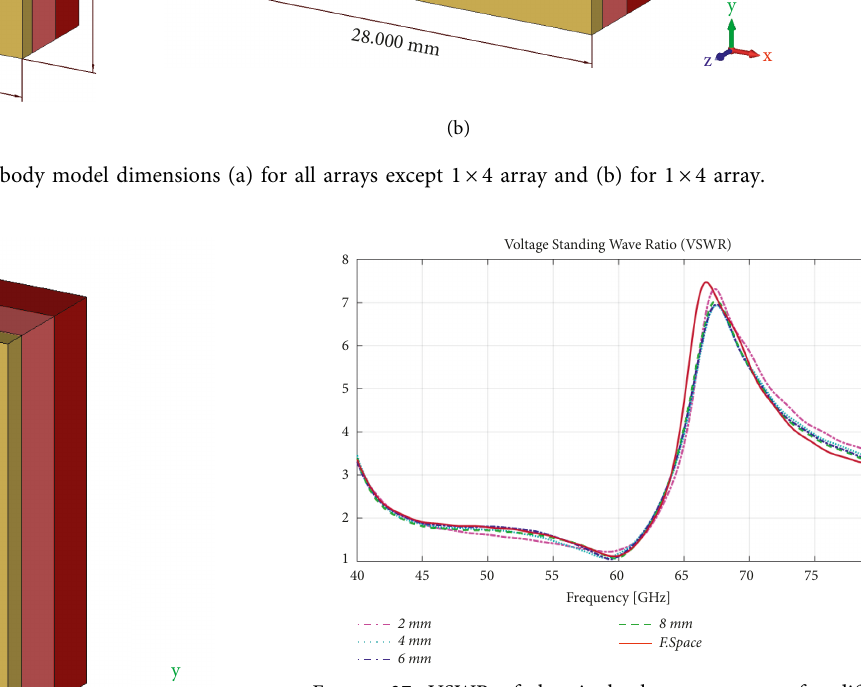
Figure 37: VSWR of the single-element antenna for different